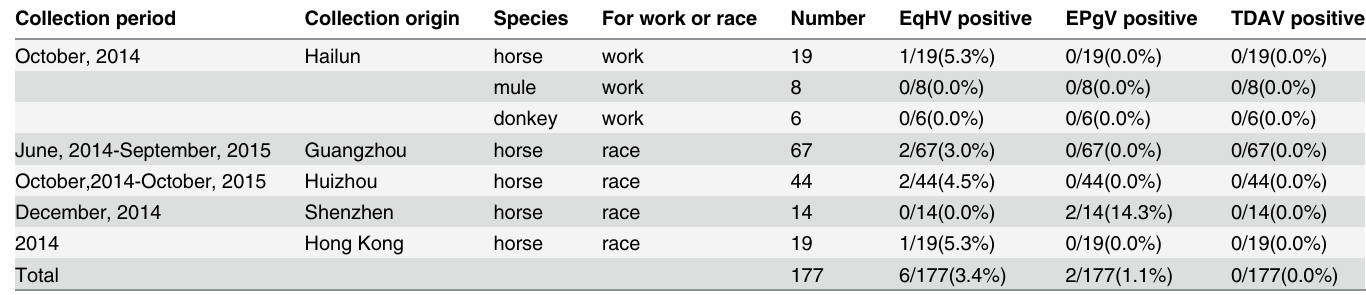
Table 1. Detailed information about collection period, geographical origin, species and number of equine samples used for molecular research hepaci- and pegiviruses in China during 2014 –